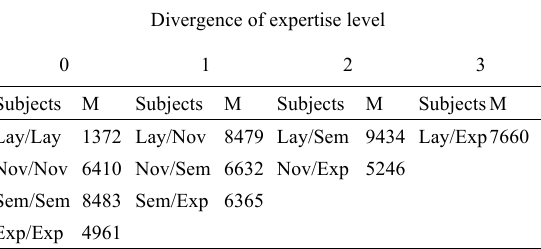
Table 7. Mean values of the distances grouped according to the divergence of the expertise level at the sculpture Moses.